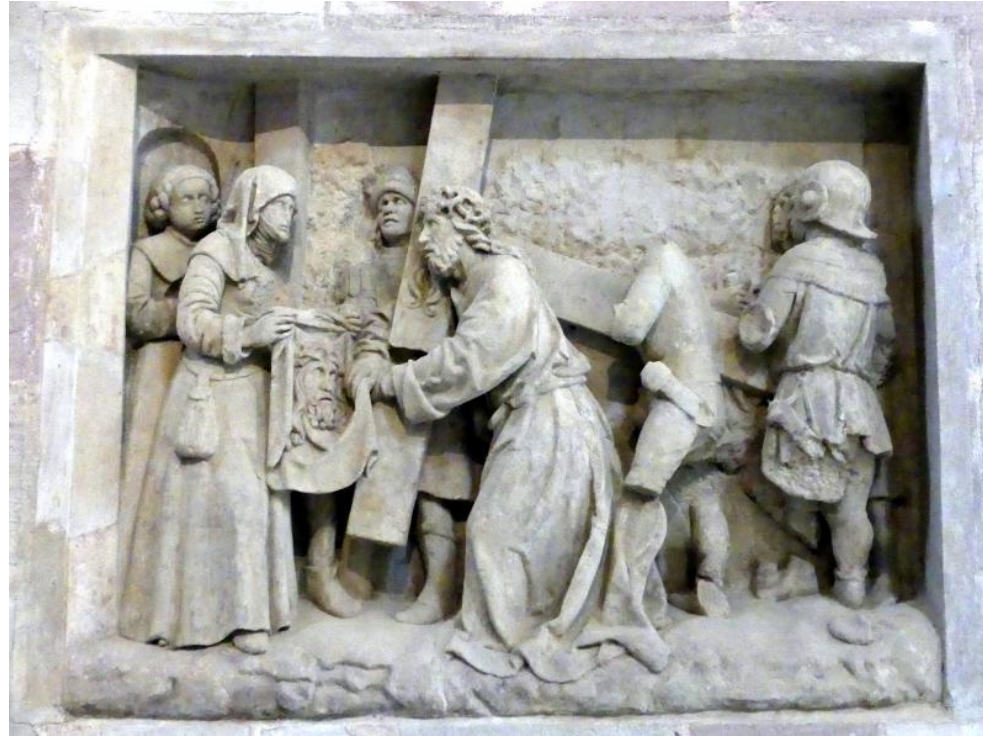
Figure 18. Kraft, Stations of the Cross , Nuremberg, Station Four (Nuremberg, Germanisches National- museum).